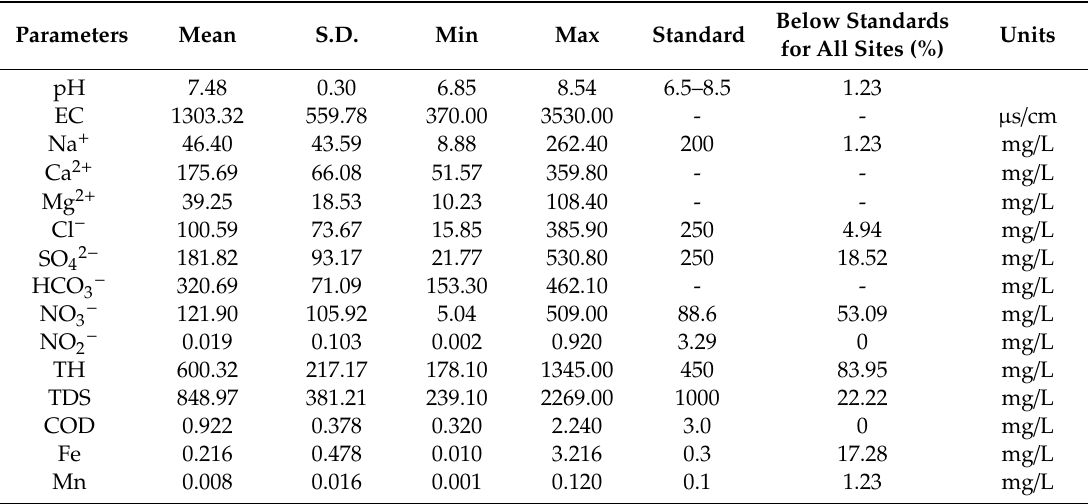
Mn 0.008 0.016 0.001 0.120 0.1 1.23 mg /